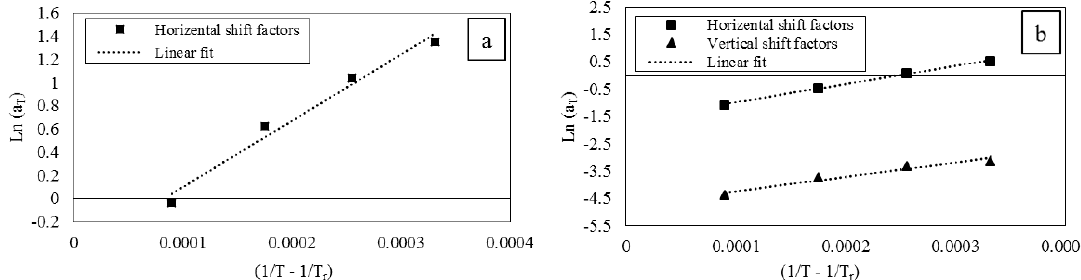
Figure 9. ( a ) Horizontal shift factors when only horizontal shift factors are used; ( b ) horizontal and vertical shift factors when both are used.